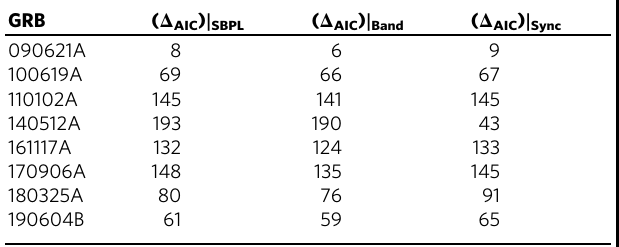
spectral parameters are the same as those adopted before. For synchrotron, we use ν c = ν m (the case ν c ≠ ν m does not improve the goodness of fi t). In order to compare the goodness of fi t of the two models, we used the Akaike information criterion (AIC), which is de fi ned as AIC ¼ 2 k (cid:2) 2ln ð L Þ , where k in the number of parameters of the model, and L is the best fi t likelihood, that is, 2ln ð L Þ ¼ (cid:2) χ 2 . In Table 2, we show the value of Δ AIC = AIC HLE − AIC AC for each spectral shape. For all cases, the adiabatic cooling is signi fi cantly favored with respect to HLE.